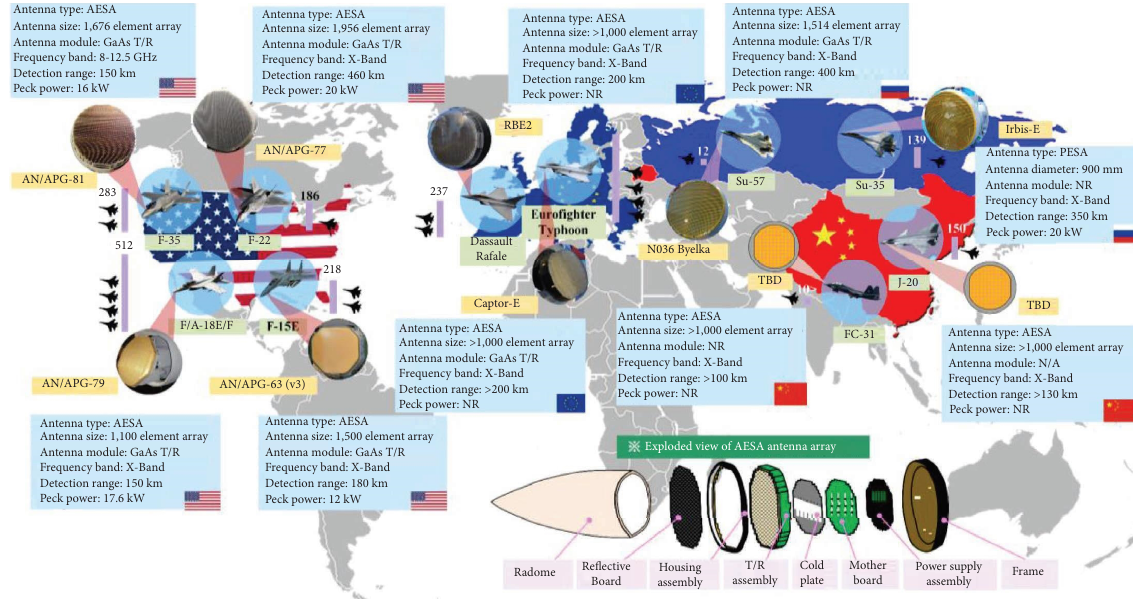
Figure 4: Top 10 most advanced fghters in the world and their